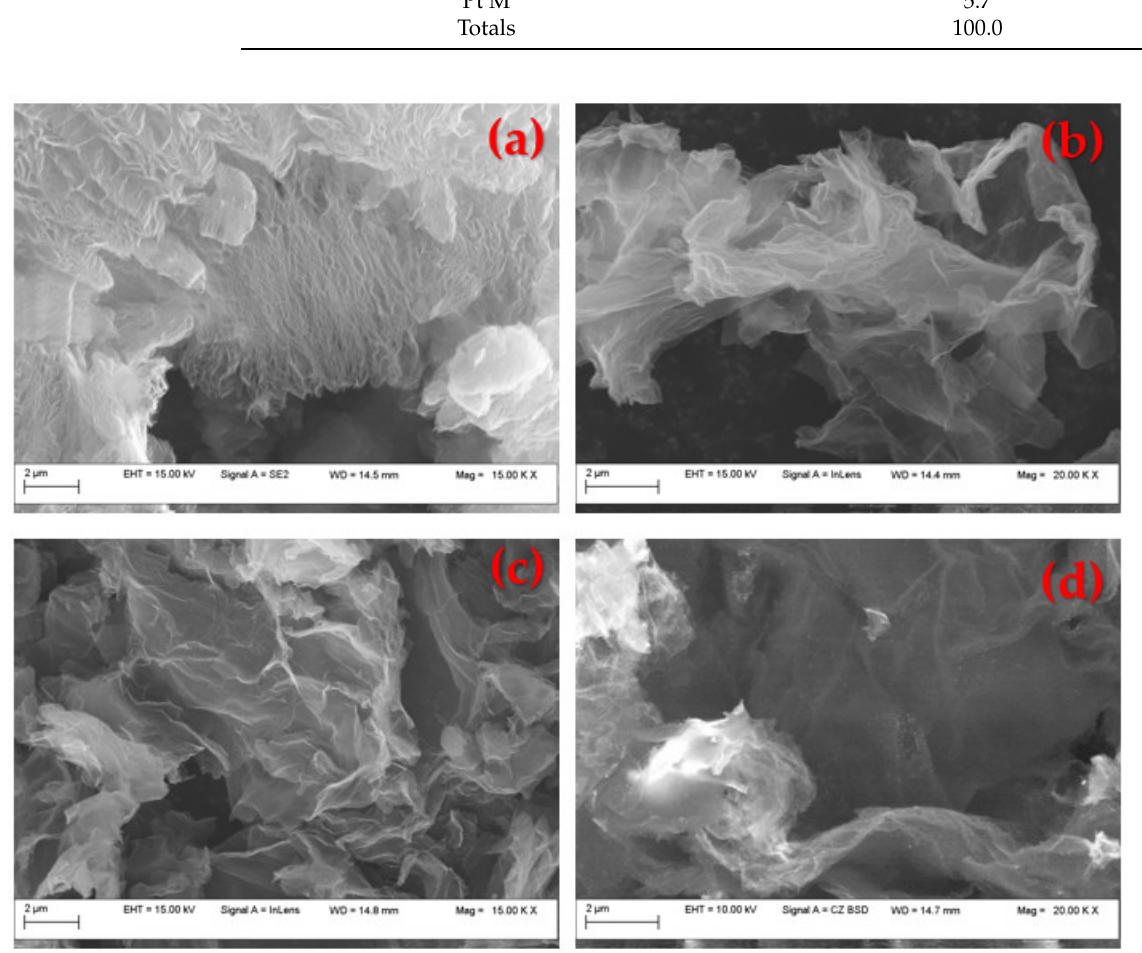
Figure 2. SEM micrographs of: ( a ) commercial graphene oxide; ( b ) PtrGO1; ( c ) PtrGO2; ( d ) PtrGO3. Table 1. The average concentration of Pt by atomic adsorption and EDX [34]. Samples